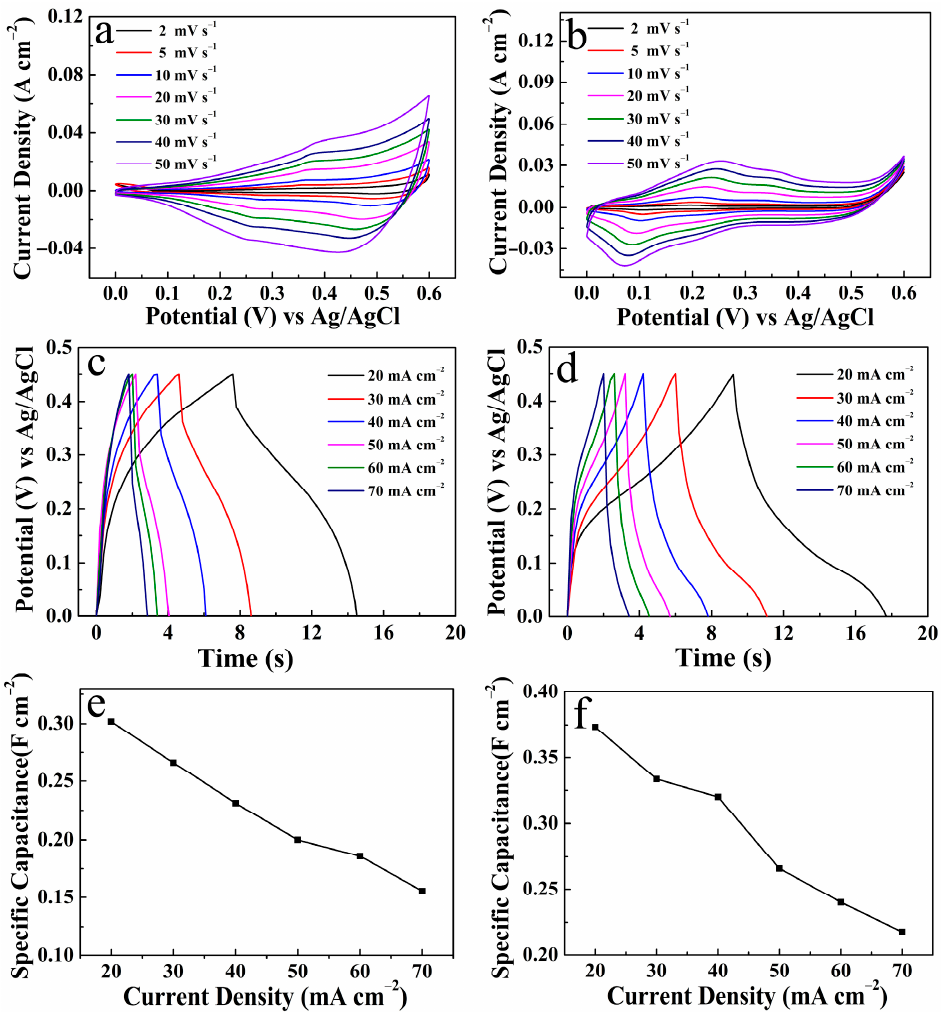
Figure 10. Electrochemical properties of CuO and NCS electrodes: ( a , b ) CV curves; ( c , d ) GCD curves; and ( e , f ) C s at different current densities.